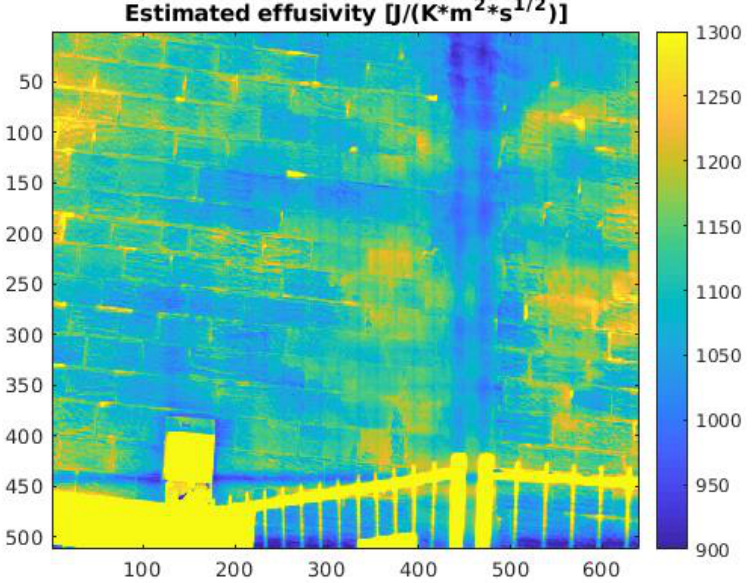
Figure 10. Estimated thermal effusivity for each pixel. Note that these results are only valid for regions that are thermally thick. Regions like the reference plates or the steel fence result in meaningless effusivity values.